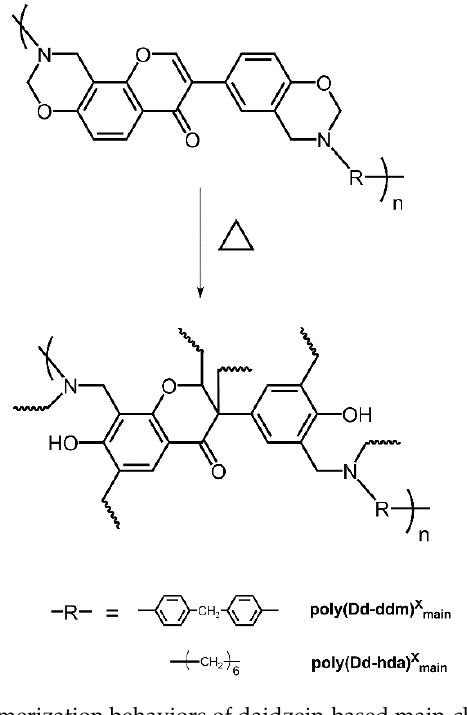
Figure 3. FT-IR spectra of poly(Dd-ddm) main ( a ) and poly(Dd-hda) main ( b ) obtained after various thermal treatments.